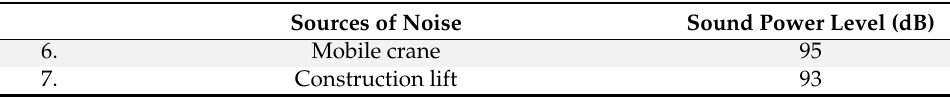
Table 21. Expected sources of construction noise.